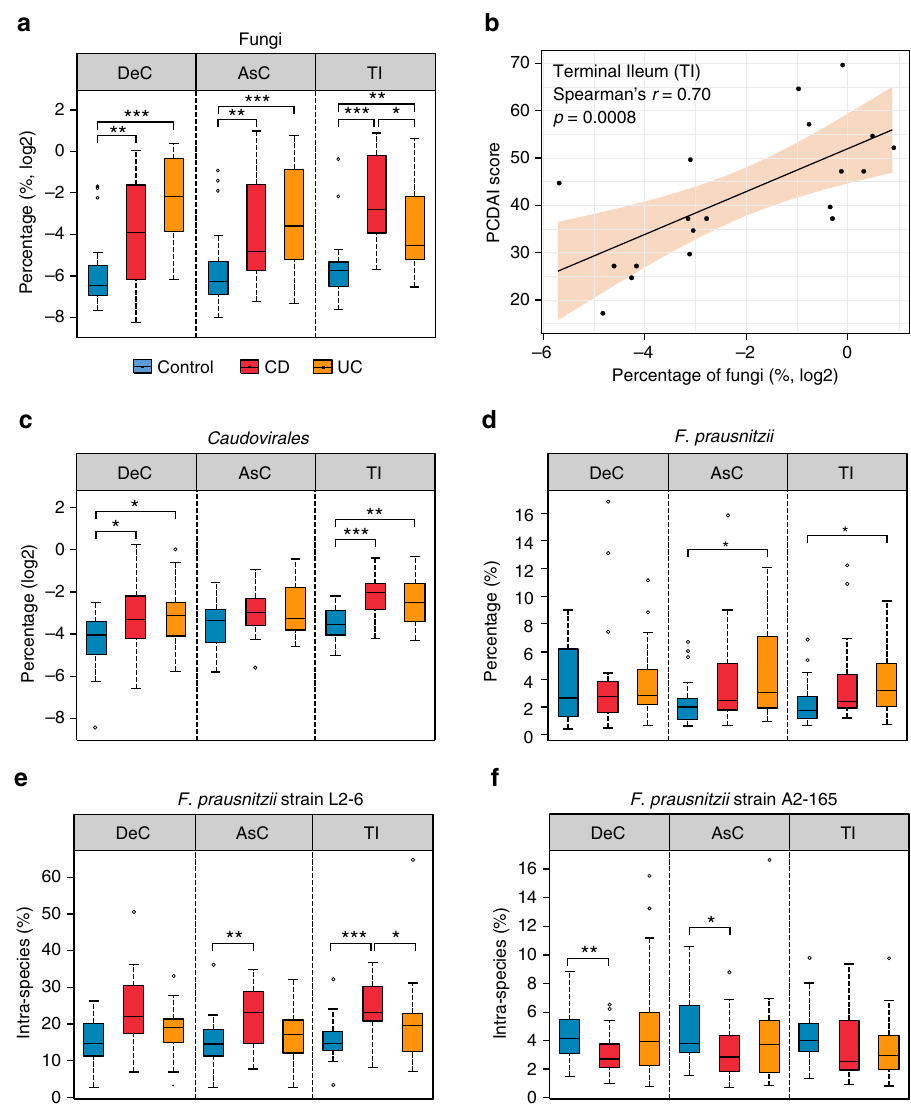
Fig. 5 Alterations of MLI microbiome composition in pediatric IBD patients. a Relative abundance of Fungi in MLI microbiome. b Representative scatter plot between the fungal abundance and CD disease severity scores. c Relative abundance of Caudovirales in MLI microbiome. d Relative abundance of F. prausnitzii in MLI microbiome. e , f Intra-species relative abundance of F. prausnitzii strain L2 – 6 and A2 – 165. For the box plot, the bottom and top of the box are the fi rst and third quartiles, respectively. The middle line represents the sample median. Whiskers are drawn from the ends of the IQR to the furthest observations within the 1.5 times the IQR range. Outliers >1.5 times the IQR are indicated with circle. * p < 0.05, ** p < 0.01, *** p <